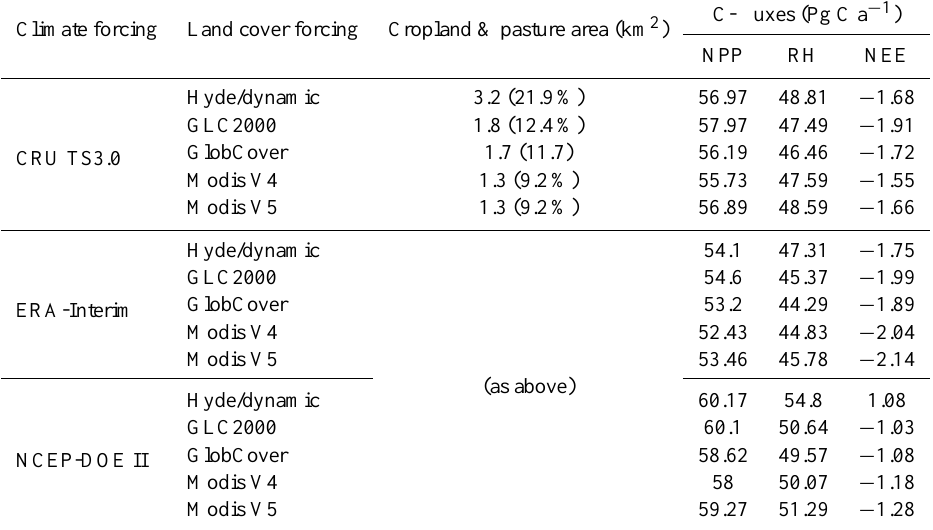
Table 3. Summary of mean annual carbon fluxes for each of the 15 global simulations, averaged over the period 1996–2005.